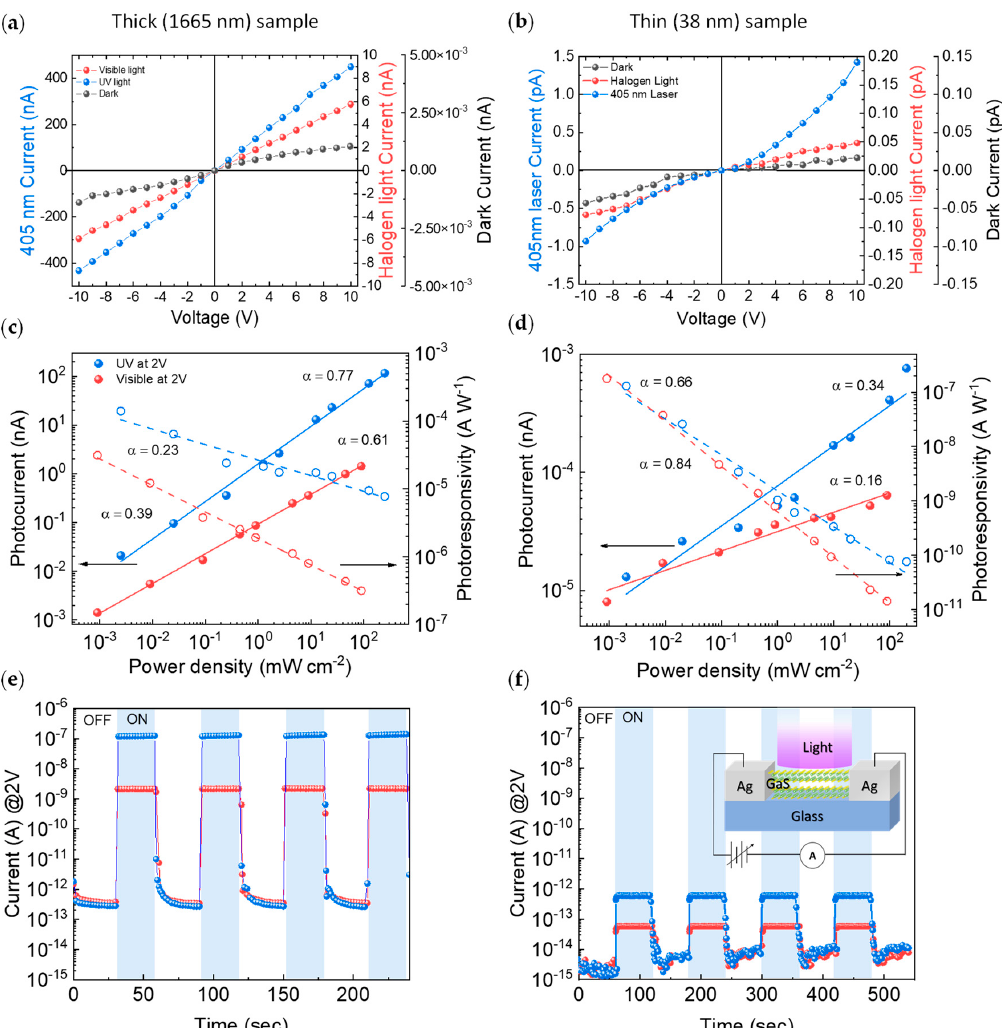
Figure 4. I–V characteristic of ( a ) thick and ( b ) thin exfoliated GaS samples in dark, visible light (100 mW cm − 2 ), and UV-light (250 mW cm − 2 ) irradiation. Photocurrent and photoresponsivity at 2 V as a function of visible and UV light power density for the ( c ) thick and ( d ) thin GaS samples; photocurrent versus time in response to light on/off under visible and UV light (the voltage is kept constant at 2 V) for ( e ) thick and ( f ) thin GaS samples.